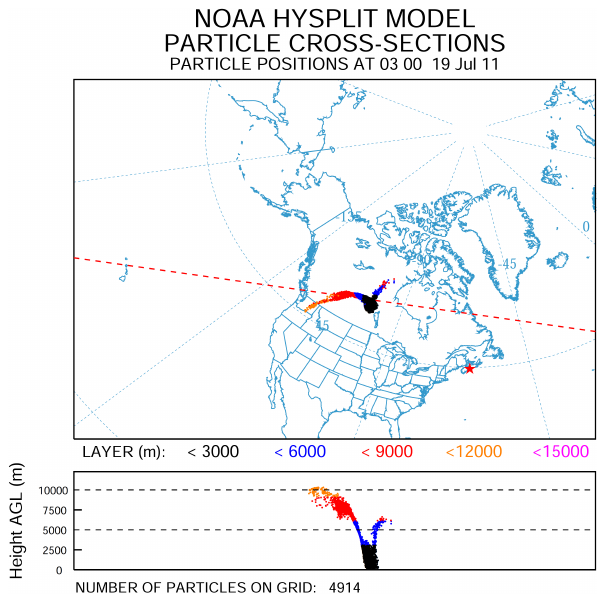
Figure 8. HYSPLIT dispersion model showing location contribu- tions to the upper plume of trace gas observed at 15:00UTC from the DGS on 20 July 2011. Particles were initialized between 7.0 and 9.0km above the DGS (marked by red star) and advected back by 36h. Contributions from below 4.0km ( ∼ 70% of par- ticles released) are concentrated at the border of Manitoba and Saskatchewan in the region where reports of smoke were observed. This time step corresponds to position 2 in Fig. 6. The lower panel shows the vertical distribution of particles along the red dashed line in the upper panel.